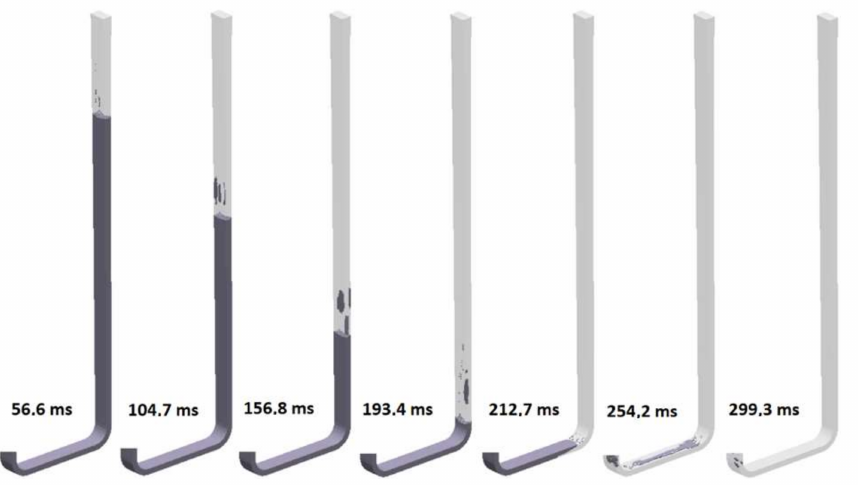
Figure 34. Air evacuation in thin rectangular sprue with hyperbolic taper (S s 9),